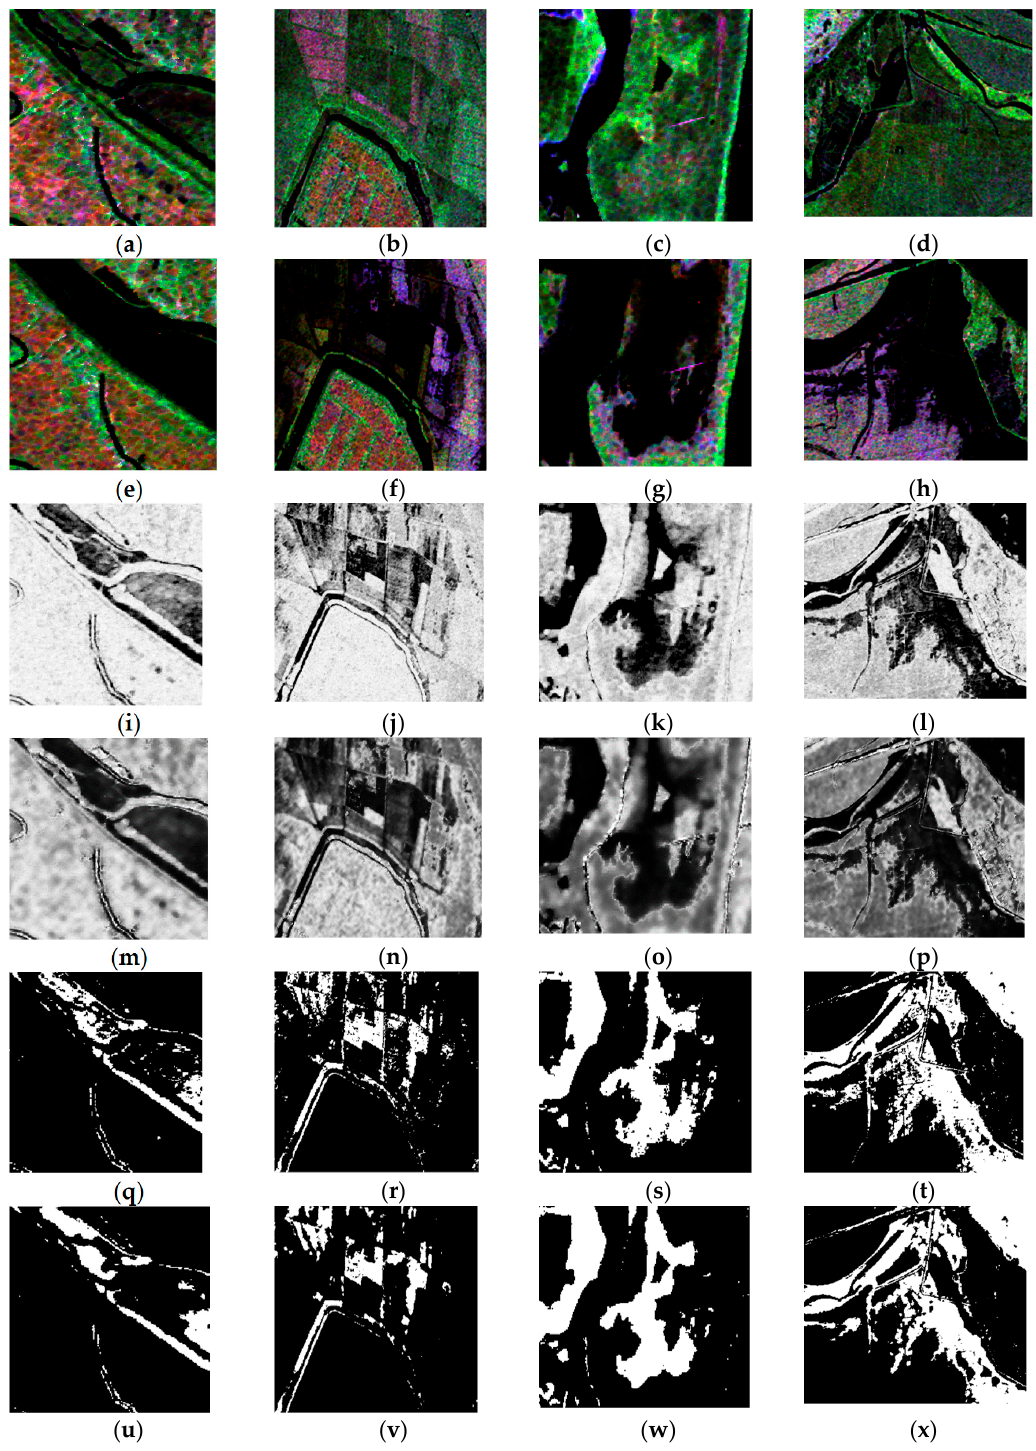
Figure 5. Selected samples of image pairs and their corresponding change detection maps: the colour composite of the image ( a )–( d ) before and ( e )–( h ) after the flooding event; ( i )–( l ) the lnQ map; ( m )–( p ) the Polarimetric Difference Image (PDI) map; ( q )–( t ) the thresholded lnQ map and ( u )–( x ) the thresholded PDI map.